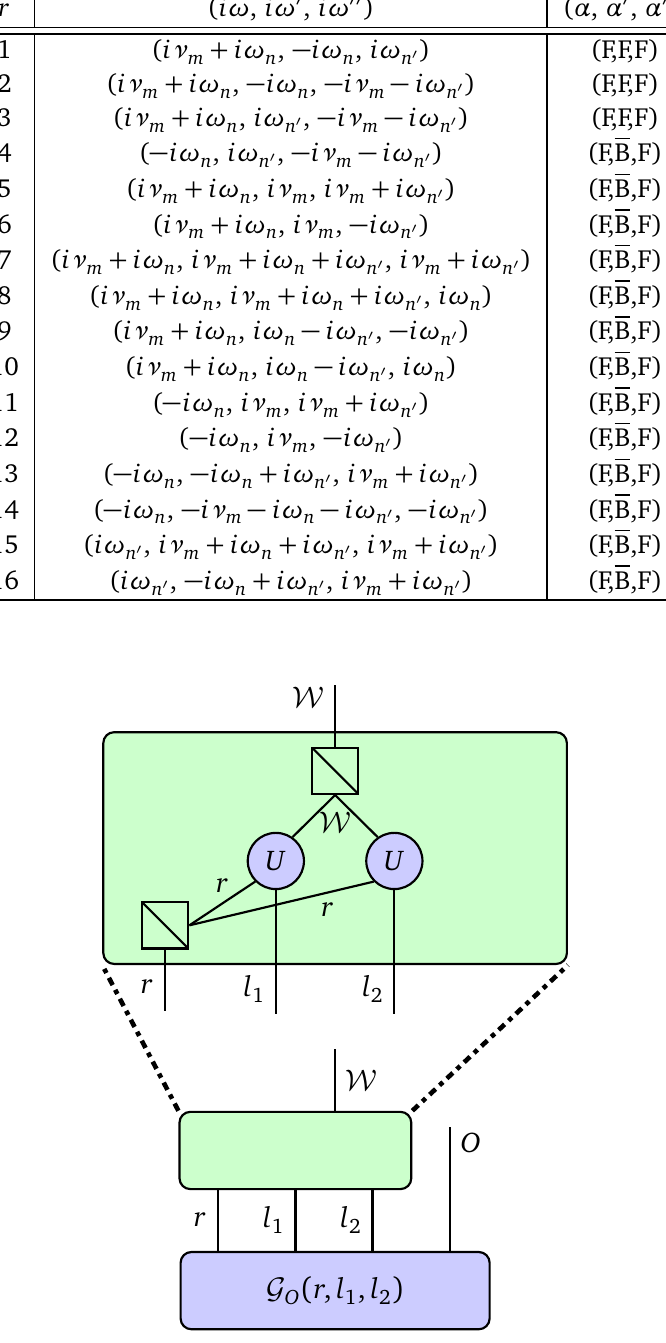
Figure 1: Graphical representation for Eq. (9). Each circle or rectangle with N legs represents a N -way tensor. When two tensors share a leg, the summation over the corresponding index must be taken. A rectangle with a diagonal line represents an identity tensor. The N -way identity tensor t is defined as t = 0 and t i 1 ··· i N